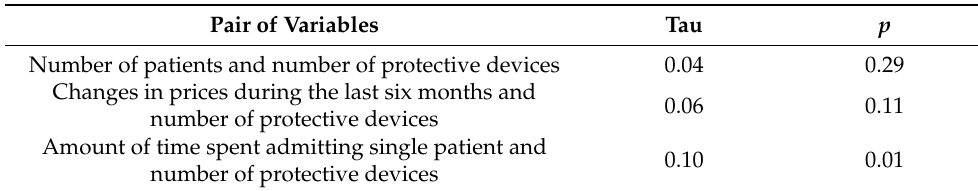
Table 9. Correlation between time spent on admitting a single patient and the number of protec- tive devices.